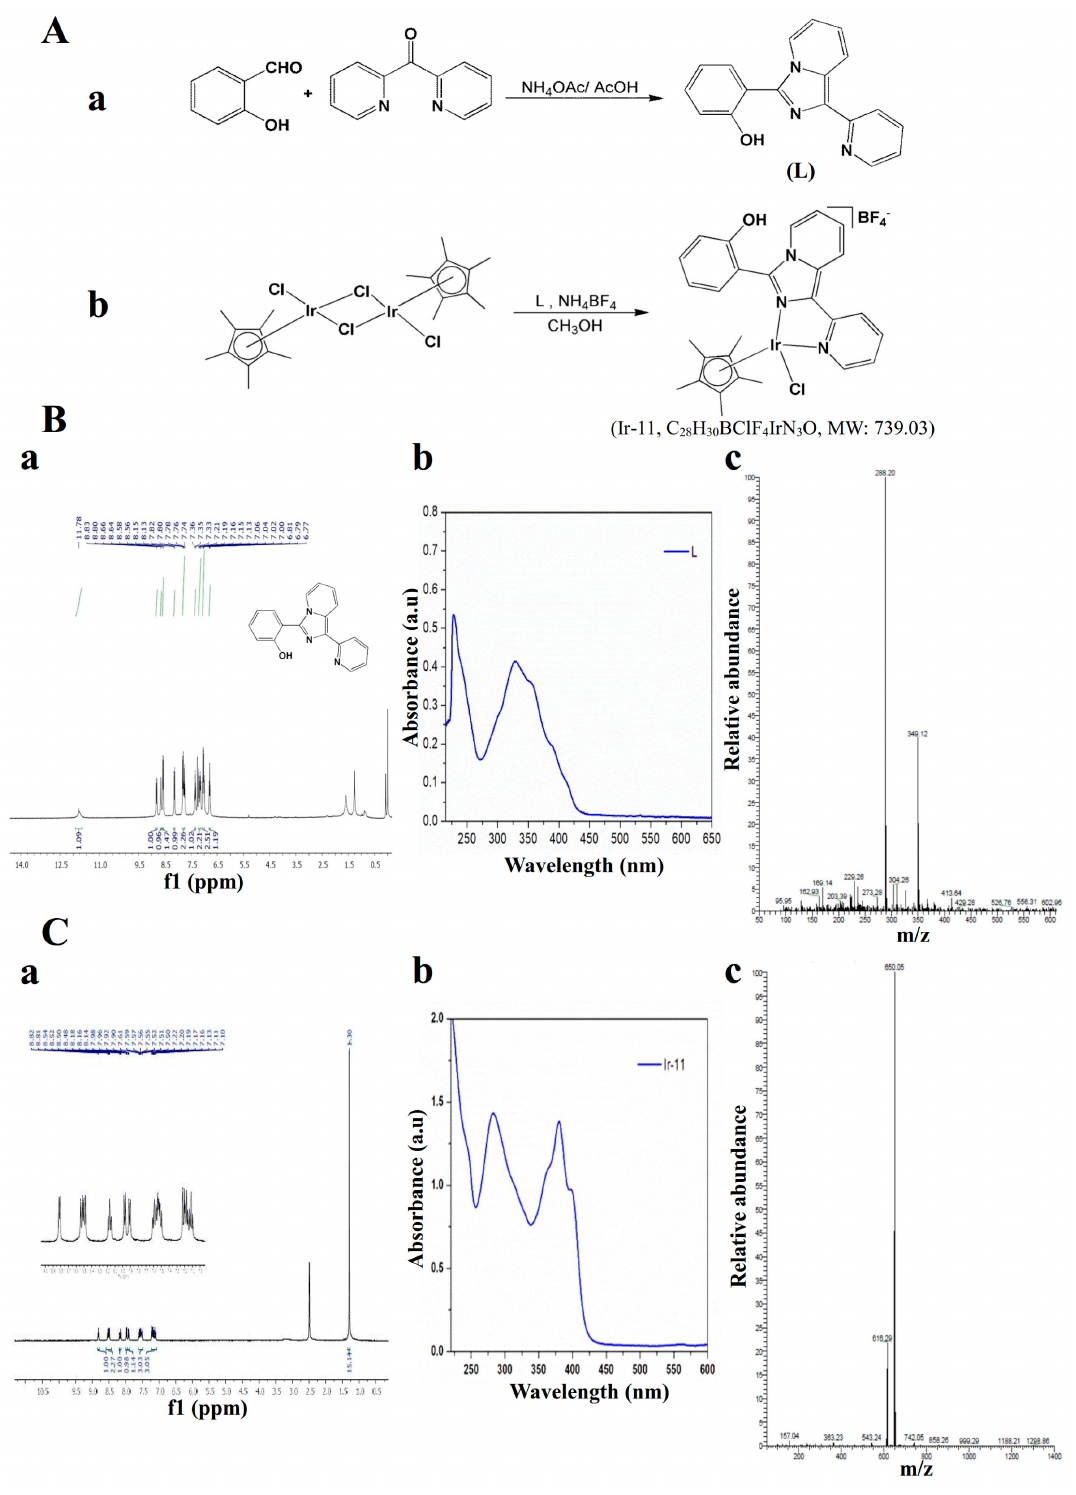
Figure 1. Chemical synthesis of Ir-11 compound. ( A ) Synthesis of ( a ) ligand (L) and ( b ) the complex [Ir(Cp*)(L)Cl]BF 4 (Ir-11); ( B ) Spectral image of ligand 2-(1-pyridin-2-yl-imidazo[1,5-a]pyridin-3-yl)-phenol ( a ) nuclear magnetic resonance (NMR) ( b ) UV–vis absorption and ( c ) electrospray ionization mass spectrometry (ESI-MS); ( C ) Spectral image of Ir-11complex ( a ) NMR ( b ) UV–vis absorption and ( c ) ESI-MS.